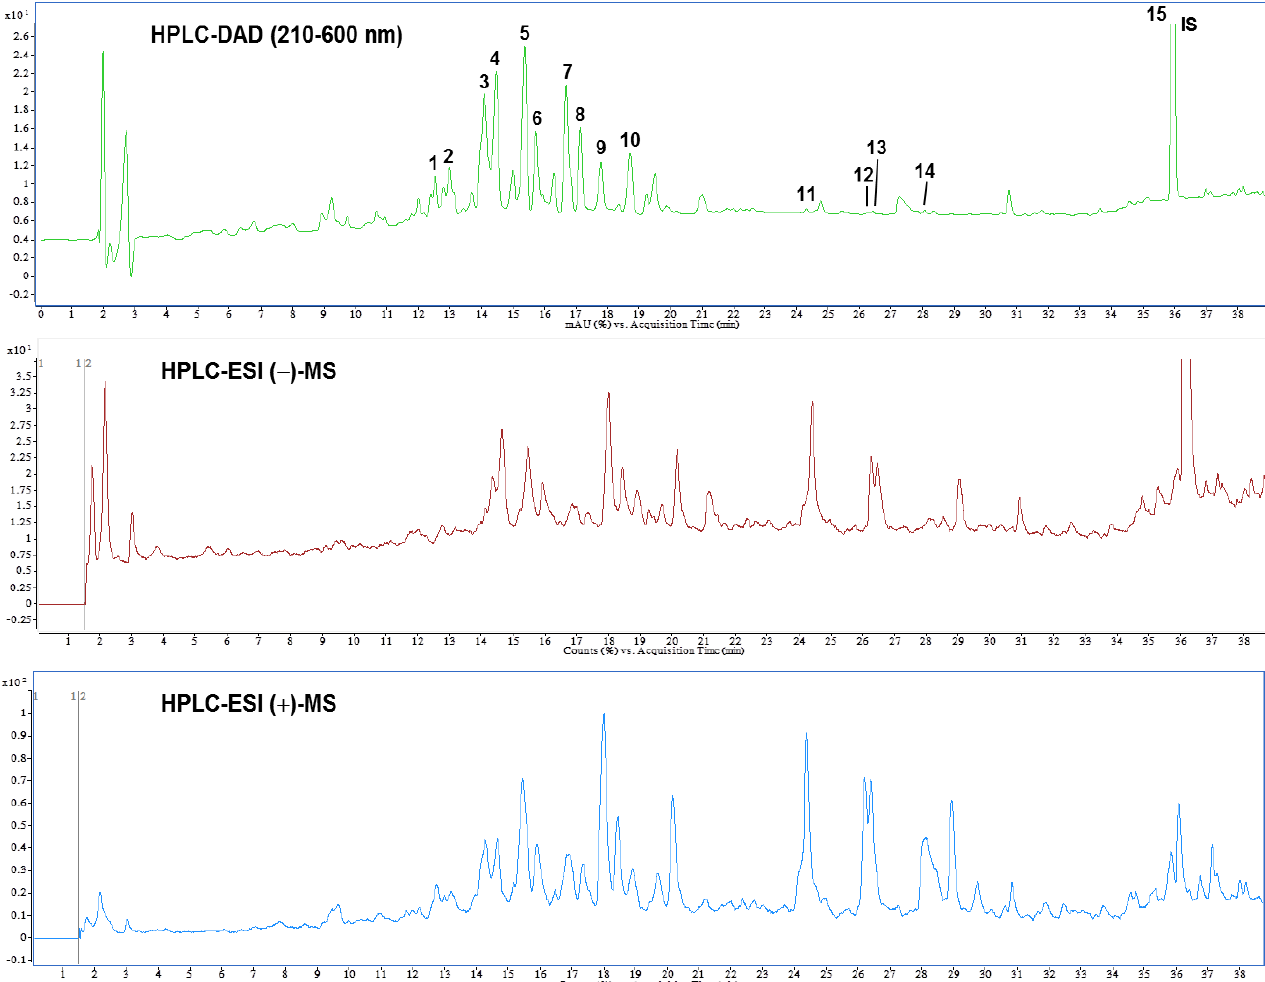
Figure 7. High performance liquid chromatogram detected at a full UV-Vis spectrum of 210-600 nm (top), and total ion chromatograms of negative (middle) and positive (bottom) ionization mass spectrometry from pepino leaf extracts. Table 2. Retention time (t R ), UV-Vis and ESI Mass spectral characteristics of isolated components in pepino leaf extracts.